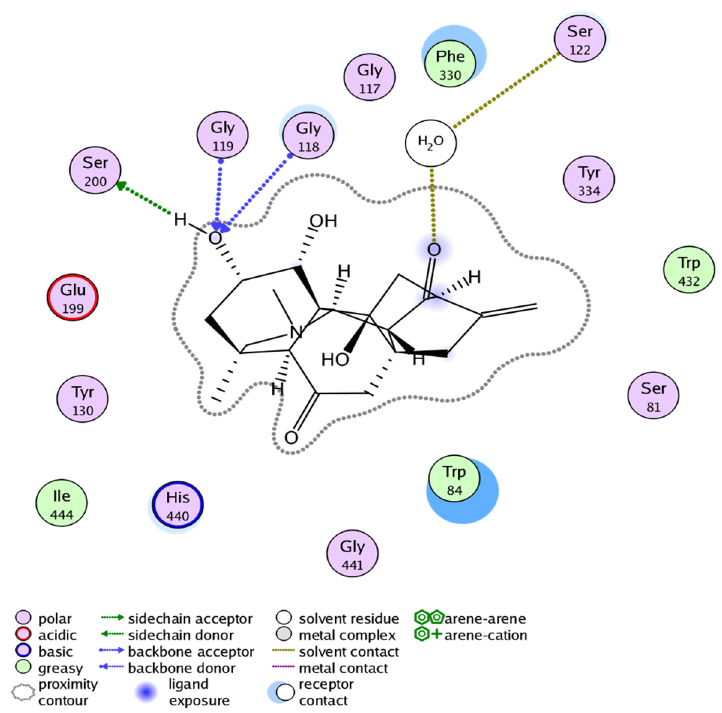
Figure 7. Docking pose of Compound 1 within cholinesterase target. (Docking score of = − 14.457).